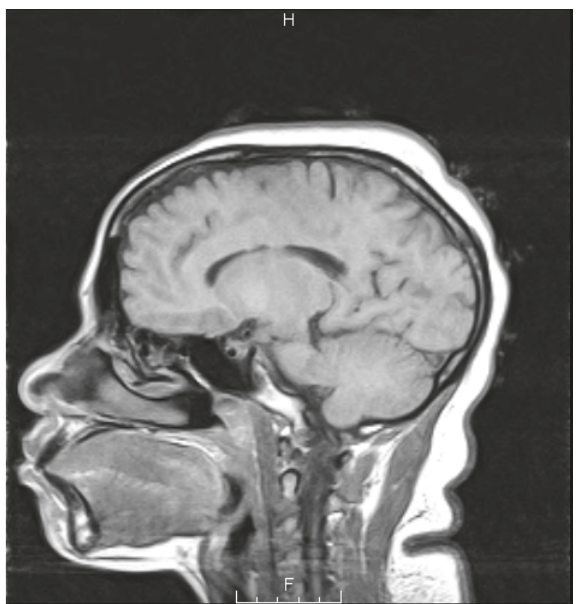
Figure 1: Sagittal T1 diffusion-weighted MRI of the pituitary